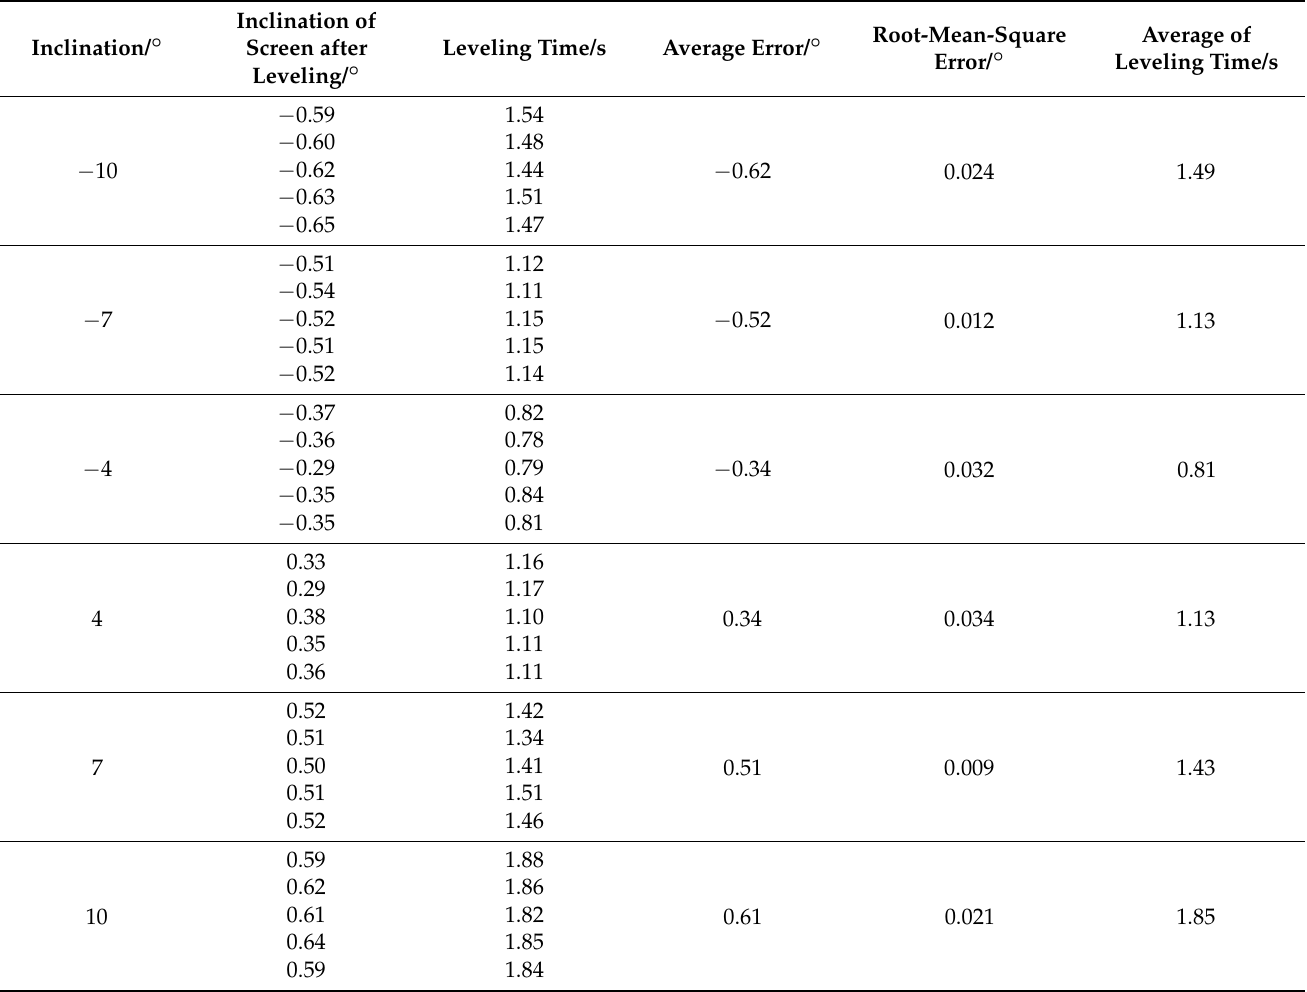
Table 6. System leveling test